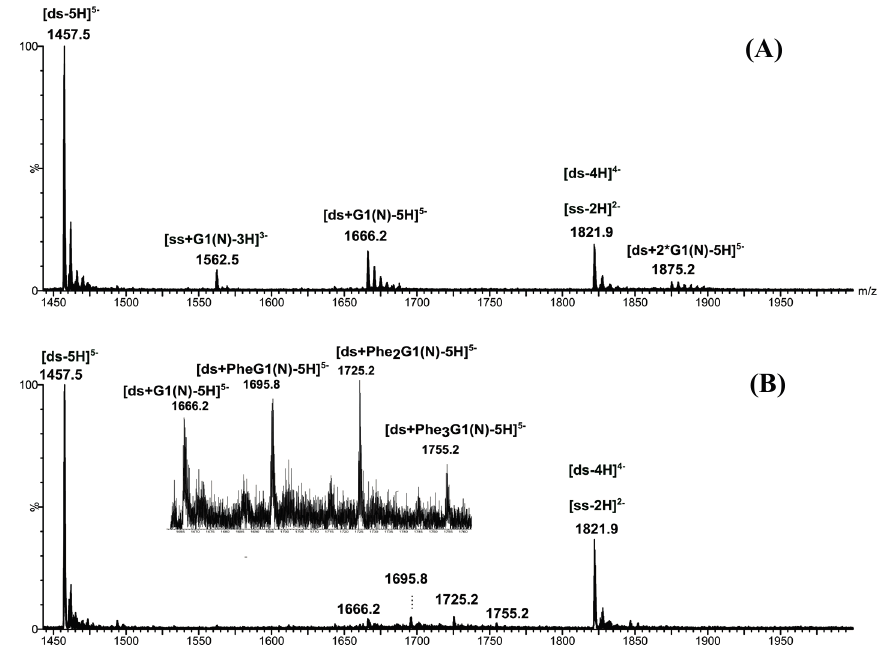
Figure 8. Negative-ion ESI mass spectra of [ ds /G1(N)] ( A ) and [ ds /Phe n G1(N)] ( B ) dendriplexes in 1:10 molar ratio solution. Insert: enlargement of m/z 1660–1763 range (dendriplexes ions